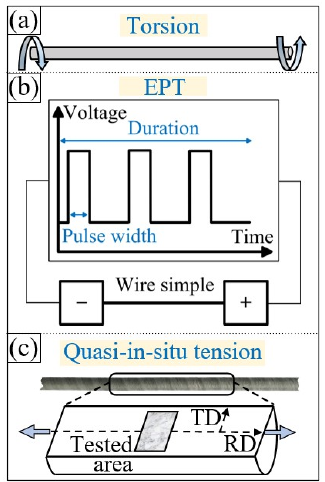
Figure 1. Schematic diagram of the ( a ) torsion, ( b ) electrical pulse treatment, and ( c ) selected position for micro observation in quasi in situ tensile test.